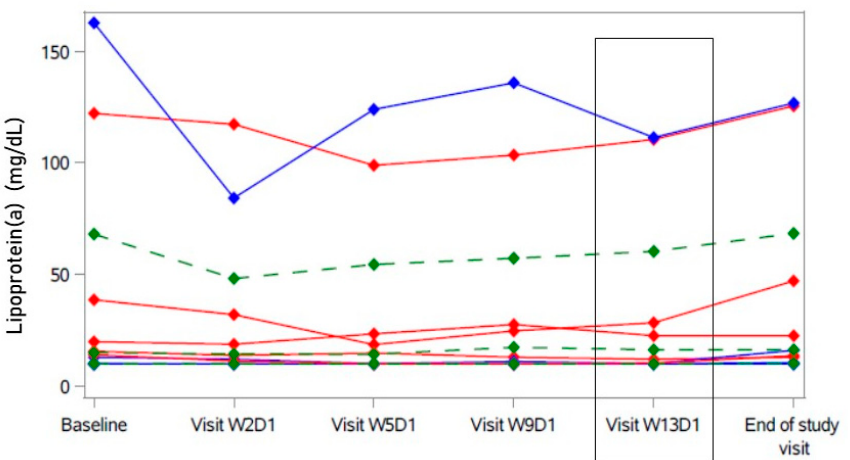
Figure 3. Course of lipoprotein(a) under bulevirtide treatment in individual participants. A secondary endpoint was change in lipoprotein(a) after 12 weeks of treatment (Visit W13D1, highlighted). Participants with decrease of LDL cholesterol (primary endpoint) > 19.6 mg/dL in blue (“responder”); participants with no decrease and decrease < 19.6 mg/dL of LDL cholesterol in red (“non-responder”). Green: Hodges–Lehmann estimator with 95% confidence interval.